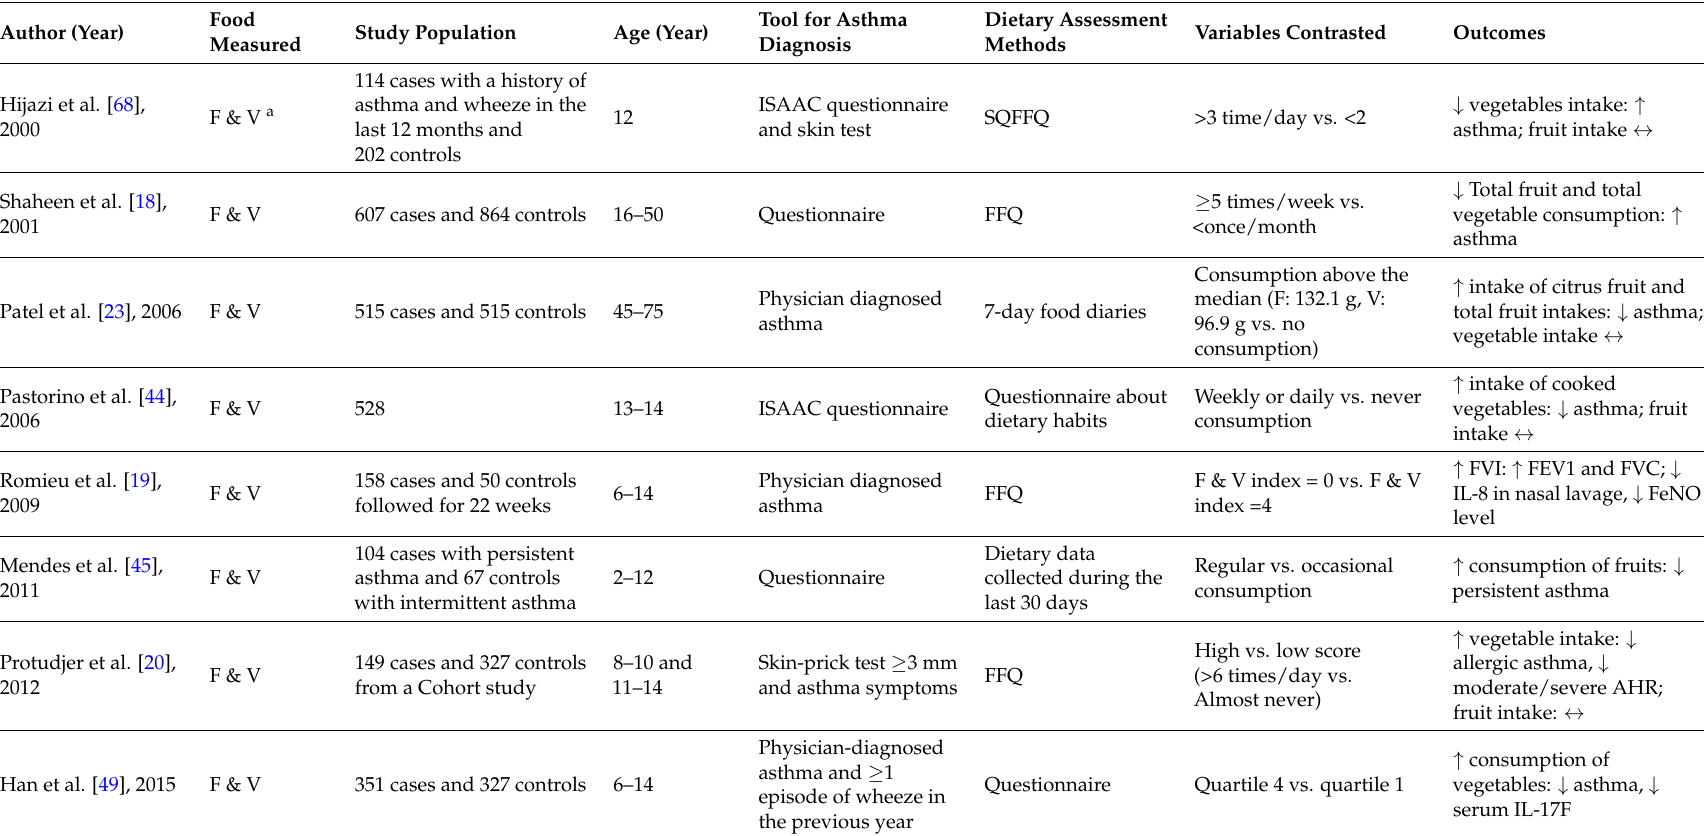
Table 2. Summary of case-control studies on the association between fruit and vegetable intake and